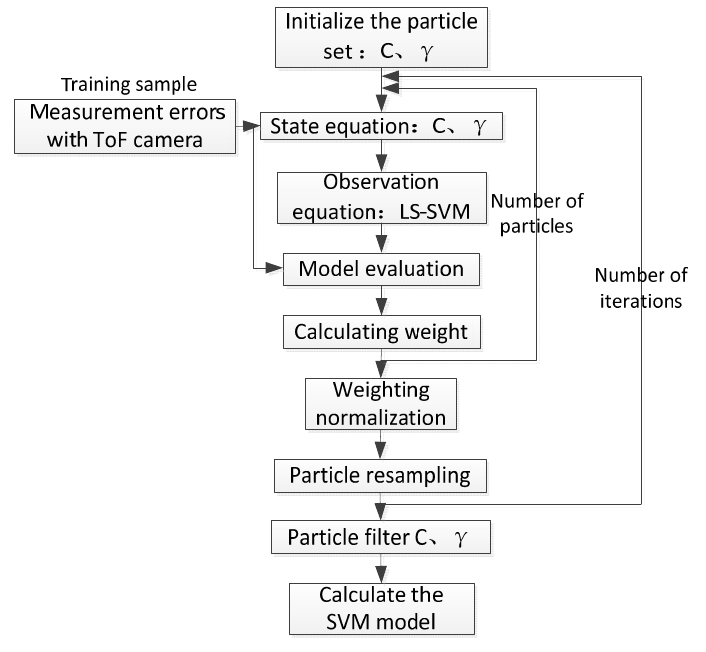
Figure 12. Process of PF-SVM algorithm.